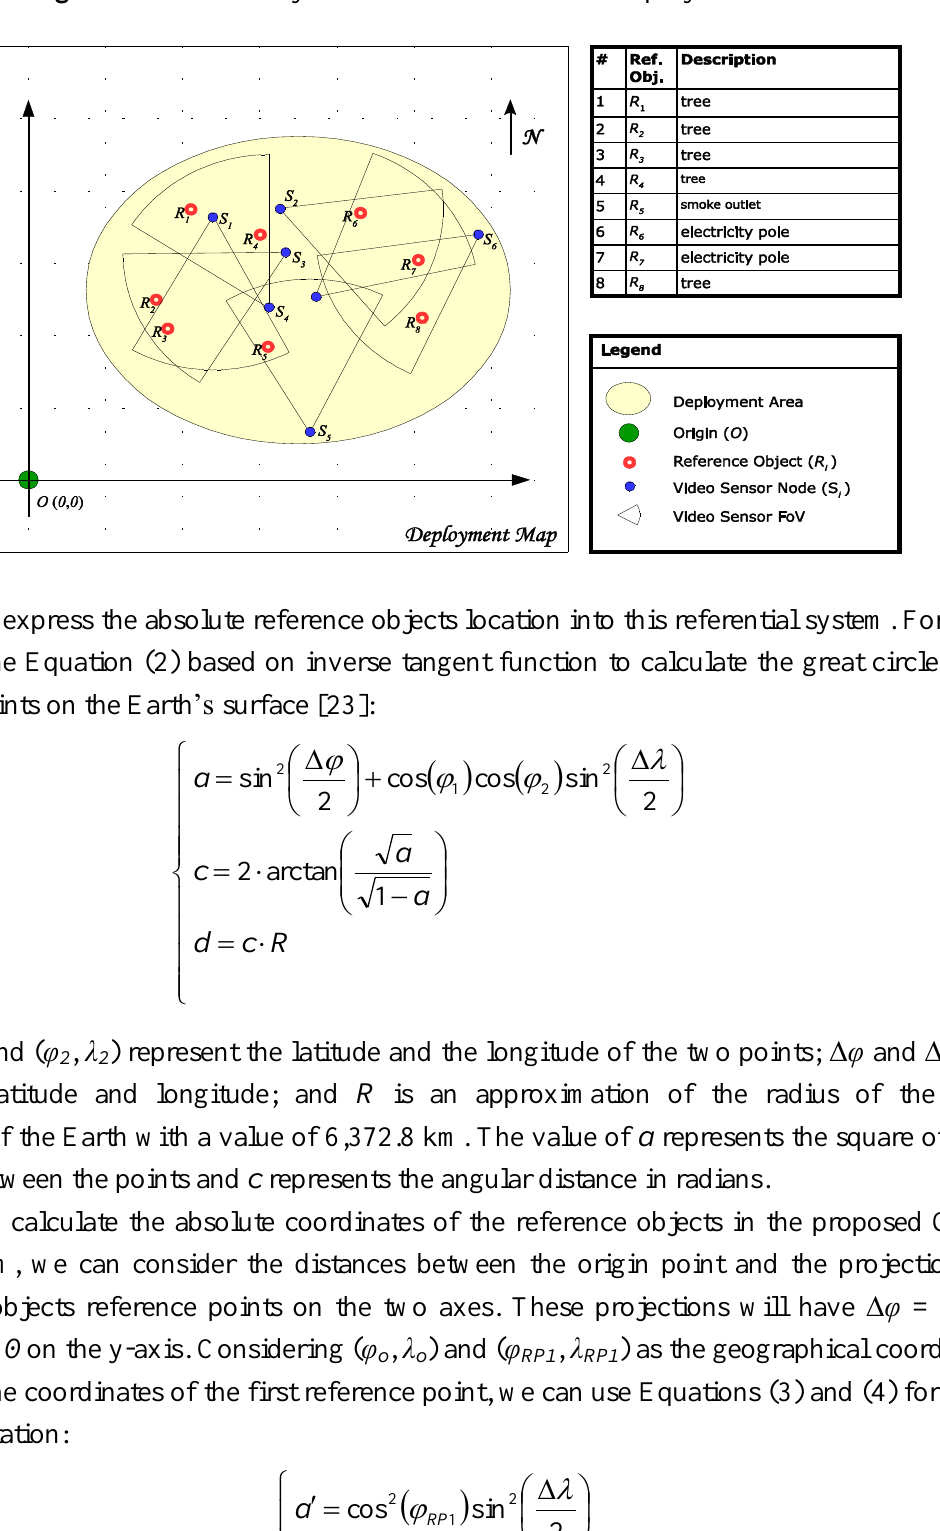
Figure 4. Reference system defined for network deployment